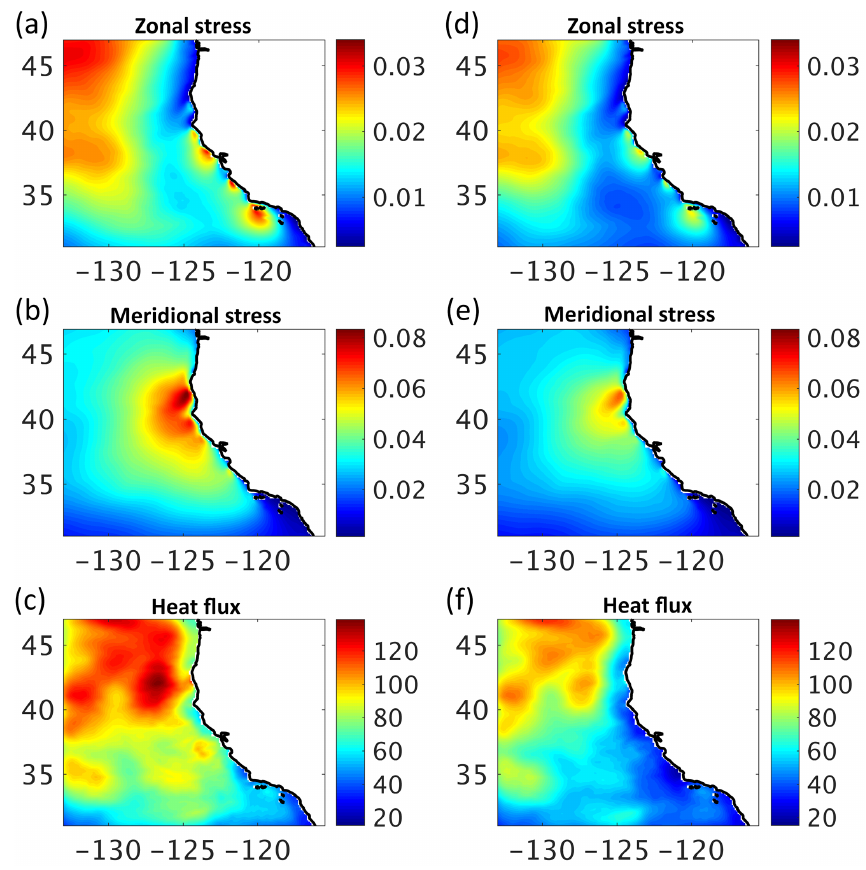
Figure 12. The rms difference between analysis and background 4D-Var estimates of (a) zonal wind stress (Nm − 2 ), (b) meridional wind stress, (Nm − 2 ), and (c) surface heat flux (Wm − 2 ) from the strong constraint calculations of N16 for 2005. Panels (d) – (f) show the corre- sponding differences for the weak constraint 4D-Var experiment